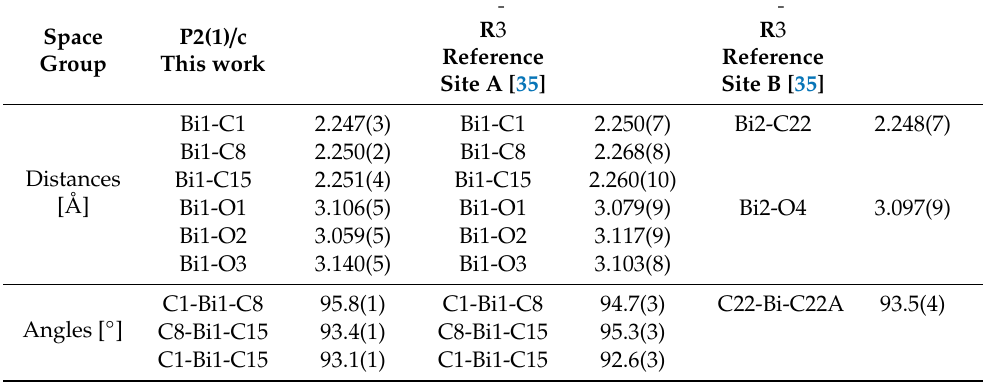
Table 6. Comparison of structural parameters for the polymorphs of